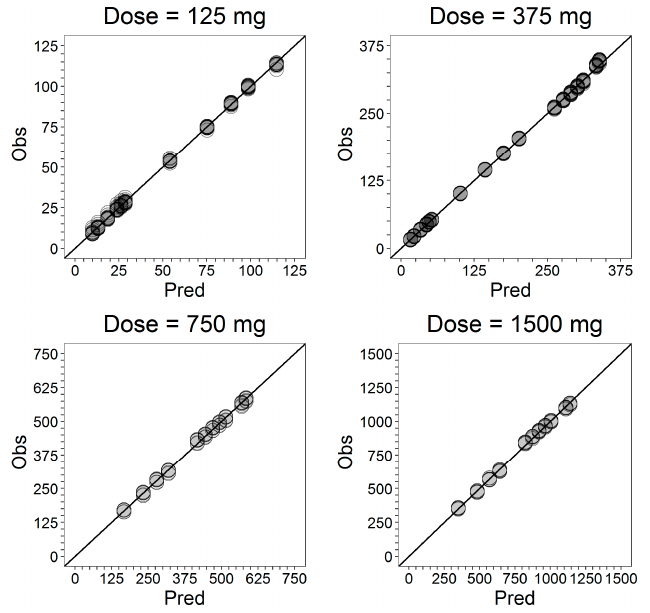
Figure 3. Observed in vitro individual data and fitted cumulative release profiles for all dose lev- els.